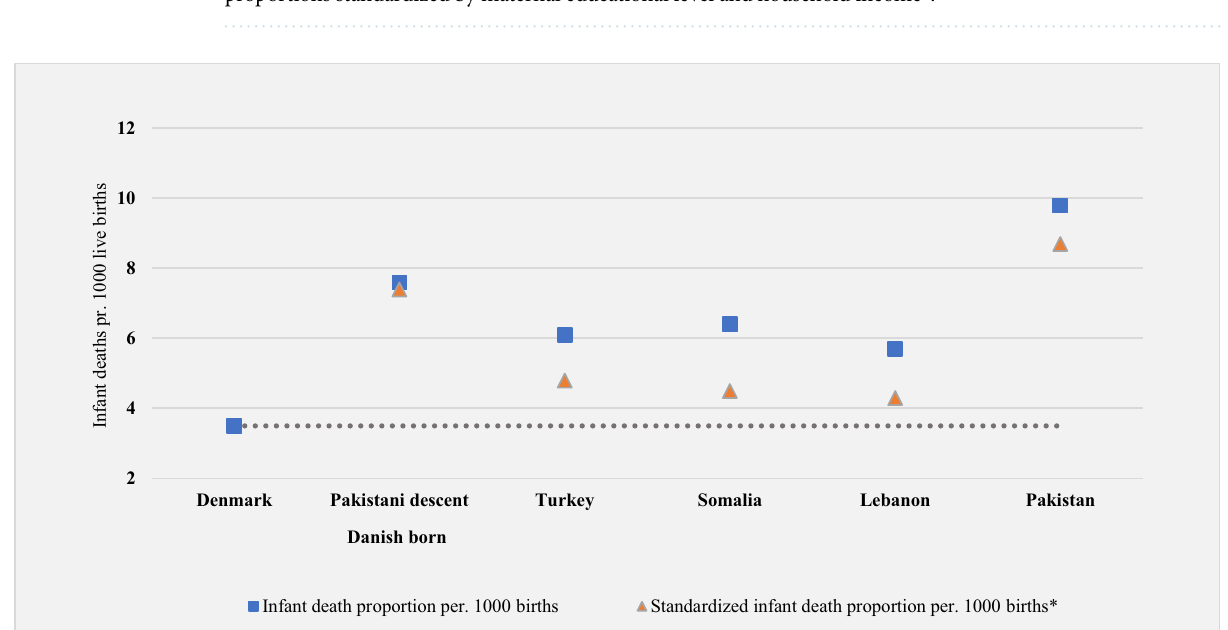
Figure 1. Stillbirth proportions by maternal country of origin in Denmark 2005–2016 and stillbirth proportions standardized by maternal educational level and household income*.